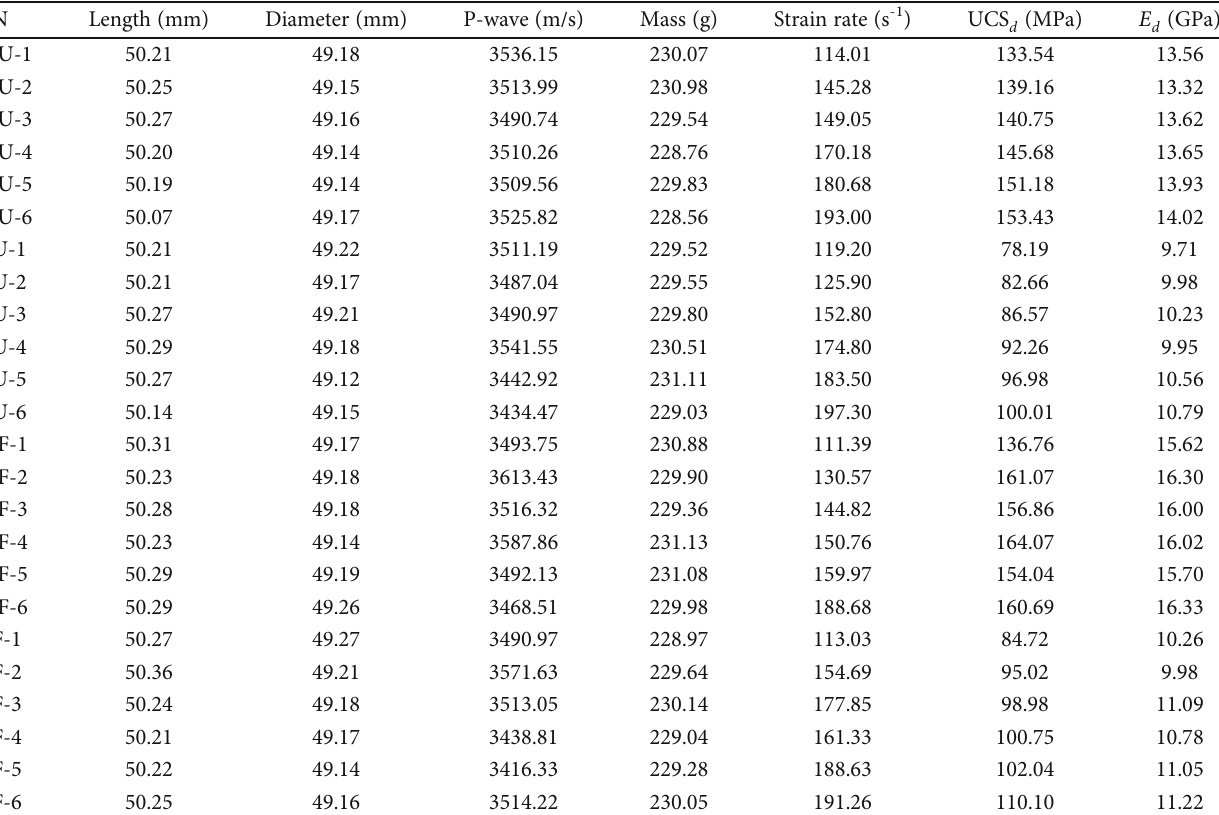
Table 2: Parameters and test results of the specimens in SHPB